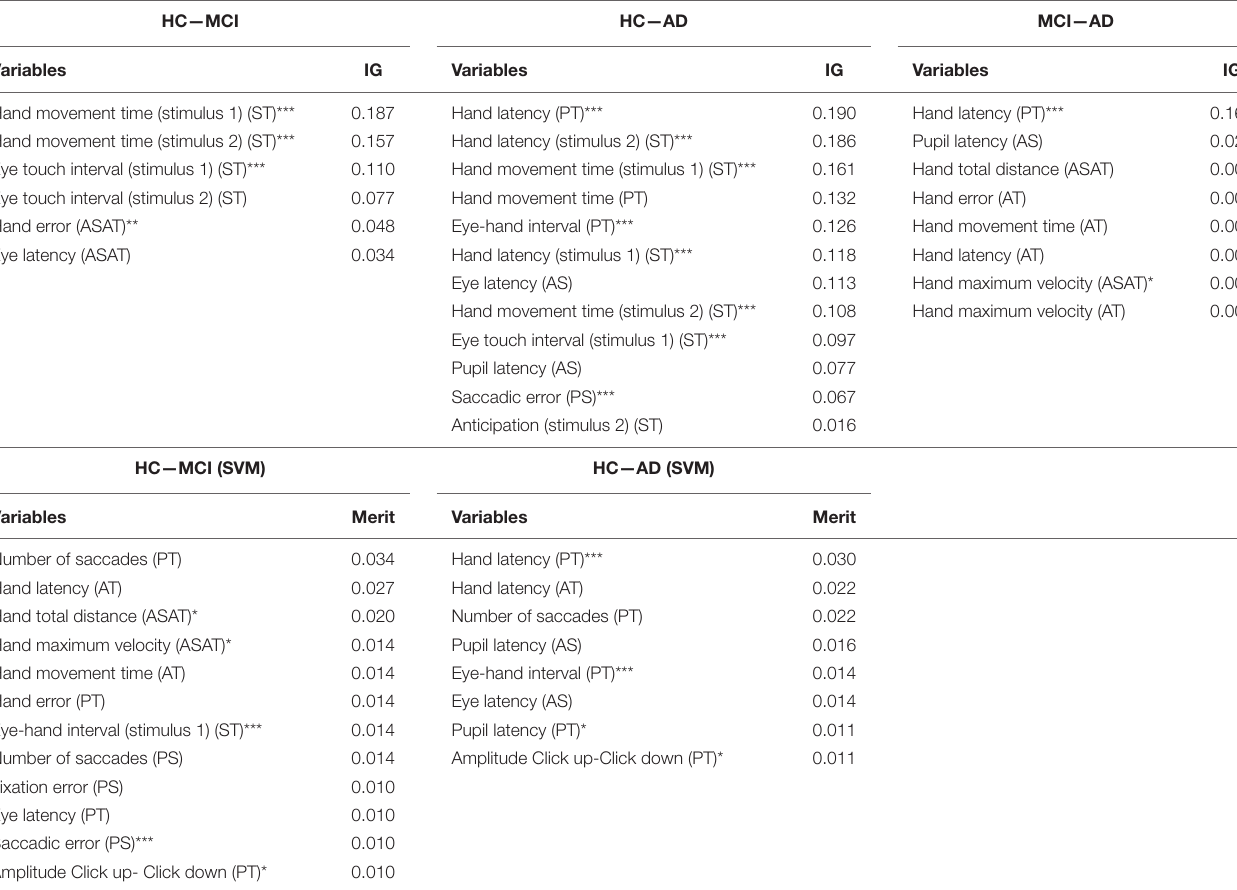
TABLE 2 | The feature selection results, ranked by IG and merit, for the HC—MCI, HC—AD, and MCI—AD datasets. HC—MCI HC—AD